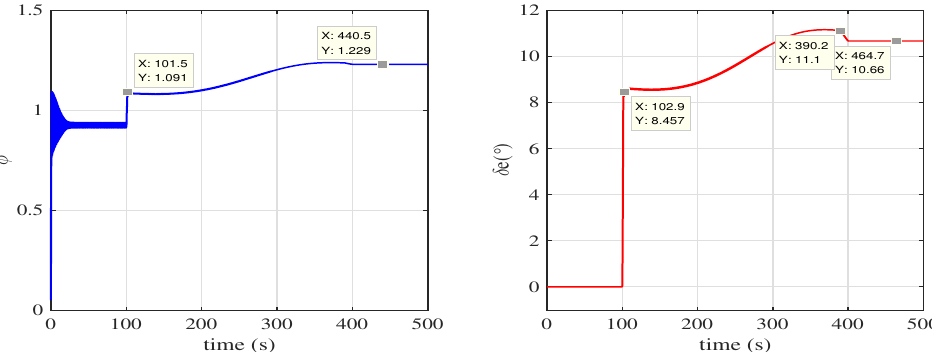
Figure 9. Control value proposed by PID controller in pitching maneuver and fault free state.